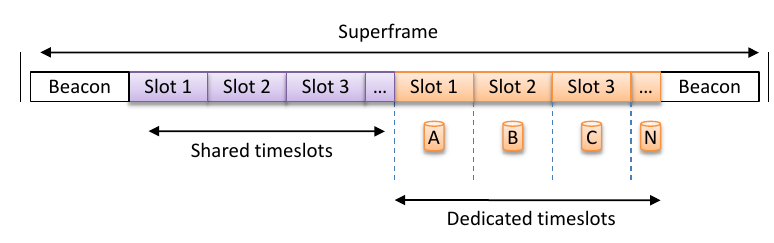
Figure 9. ZigBee